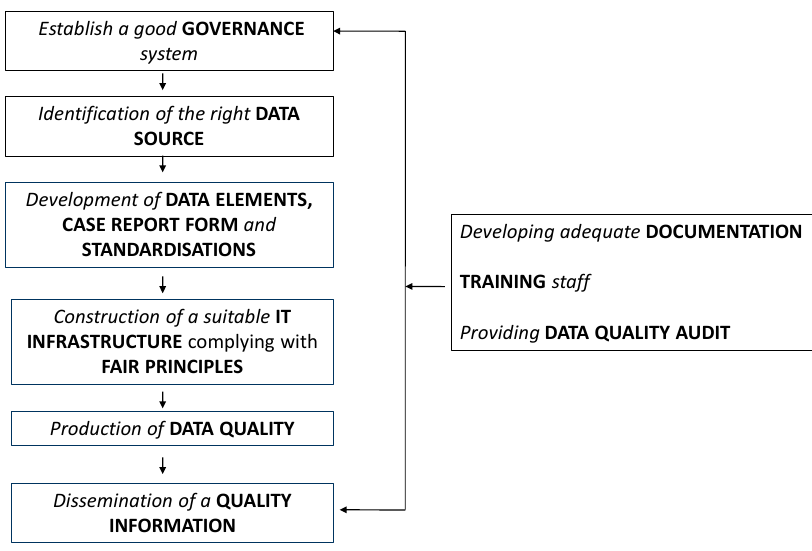
Figure 1. A framework for quality management of RD registries.